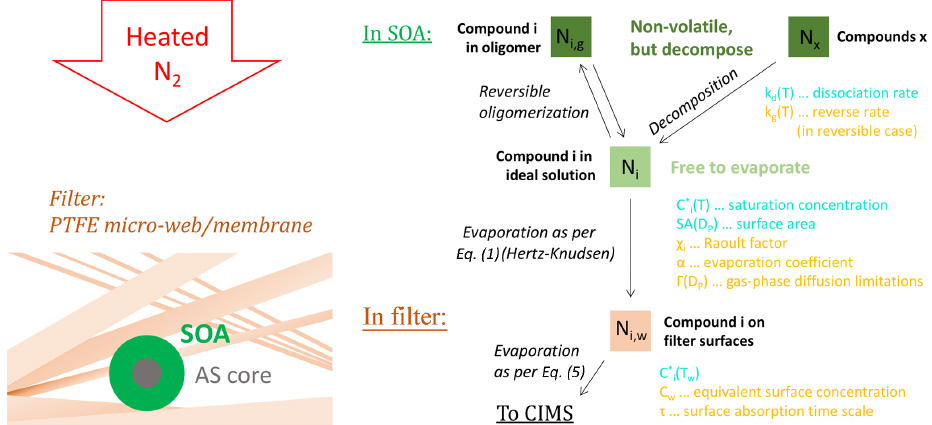
Figure 1. Schematic of the processes implemented in our model. The left-hand-side drawing gives an impression of the overall situation: an SOA particle (green), in this case with a core from an ammonium sulfate (AS) seed particle (gray), is deposited on the FIGAERO collection filter and exposed to a heated flow of N 2 . The core of the filter is a microporous membrane composed of a network of PTFE fine fibers (a.k.a. fibrils; beige). These fibrils are not accurately depicted here; the drawing is rather supposed to convey that the deposited particles are likely nested inside a complex network of fibrils that provide a large total surface area. The right-hand side summarizes the processes that are simulated for molecules of a certain compound i ( N i ). Included is a list of factors that chiefly control these processes: factors contributing to evaporation are colored cyan; factors inhibiting evaporation are colored